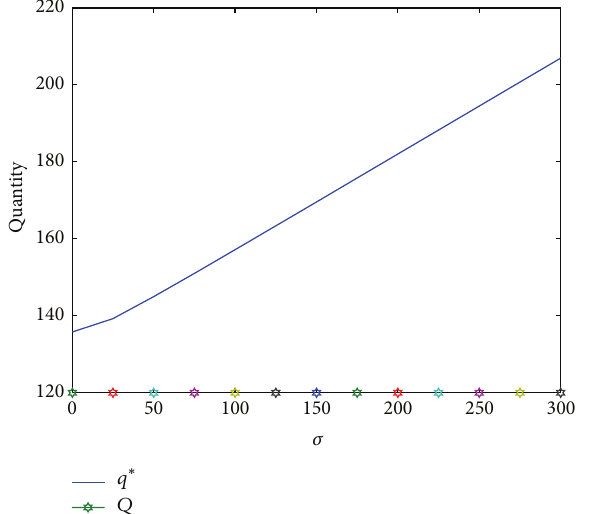
Figure 11: Impact of 𝛼 2 on ordering quantity under demand certainty and uncertainty.